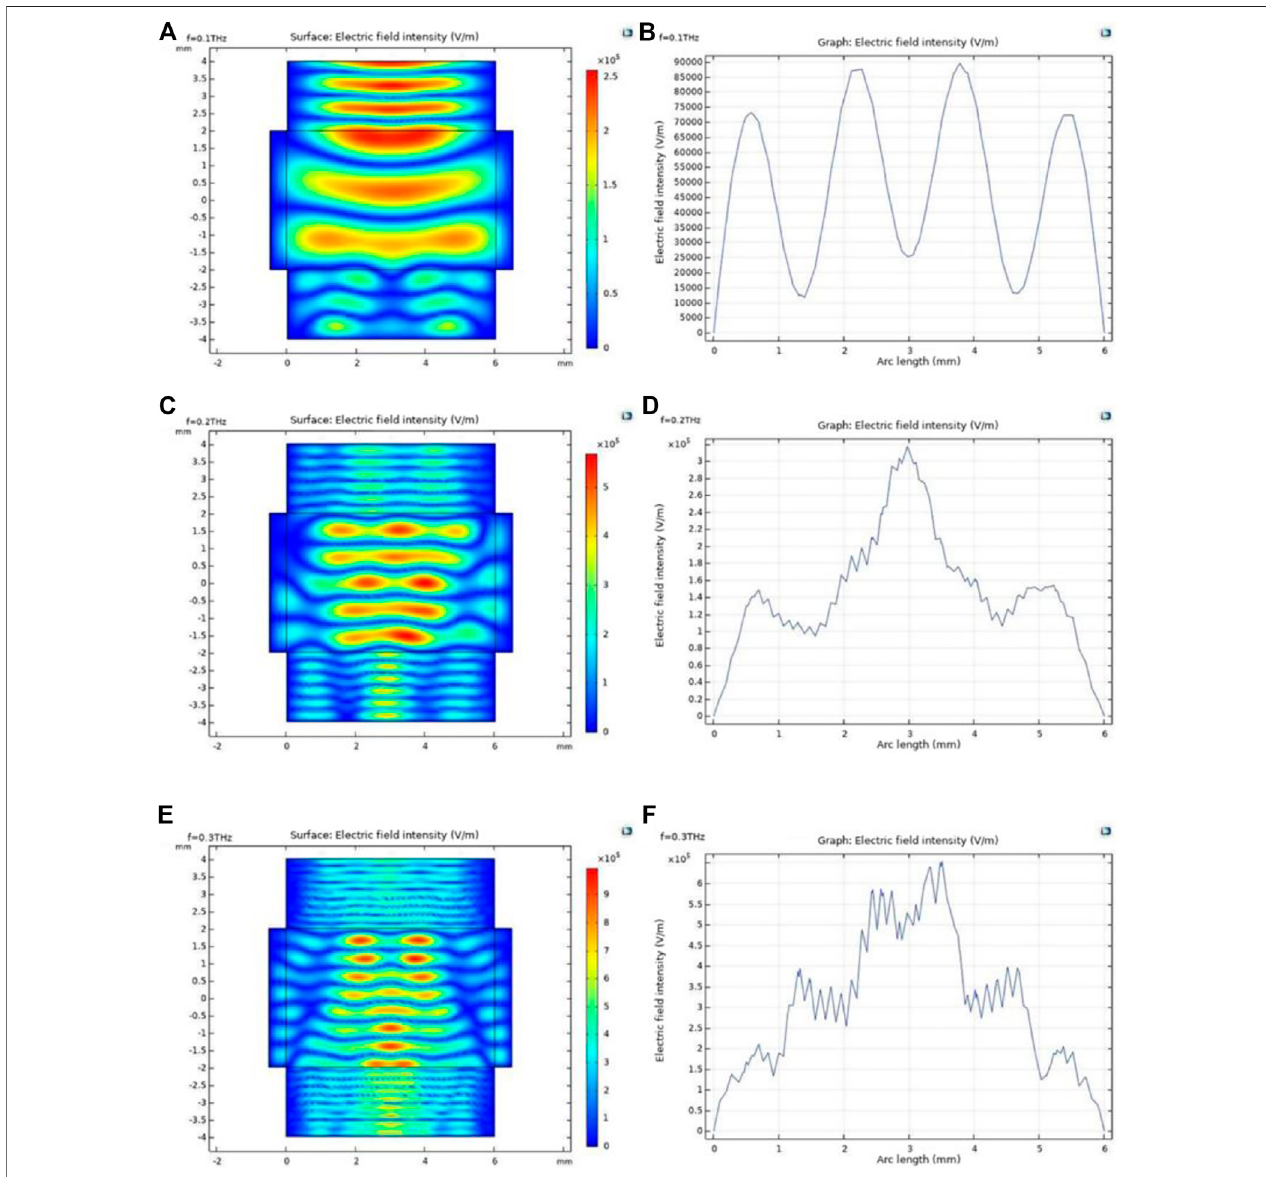
FIGURE 6 | Electric fi led intensity distribution of discharge interval (left column) and the distribution of THz electric fi eld along the horizontal line of y (cid:2) − 2.5 mm after it passing through the discharge region (right column) at different THz frequencies. (A,B) f (cid:2) 0 . 1THz; (C,D) f (cid:2) 0 . 2THz; (E,F) f (cid:2) 0 . 3THz.